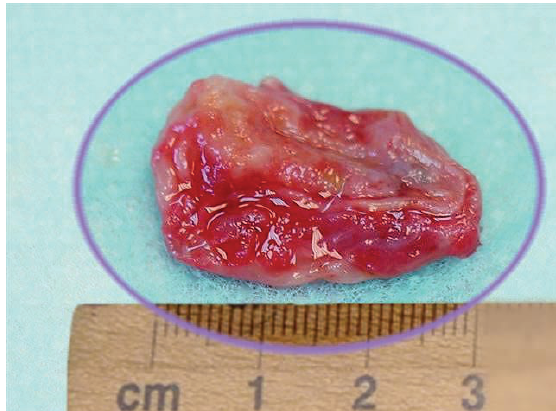
Figure 4. Mucocele upon removal from the right cheek and evacuation of its fluid contents. Morphological result: mucocele.